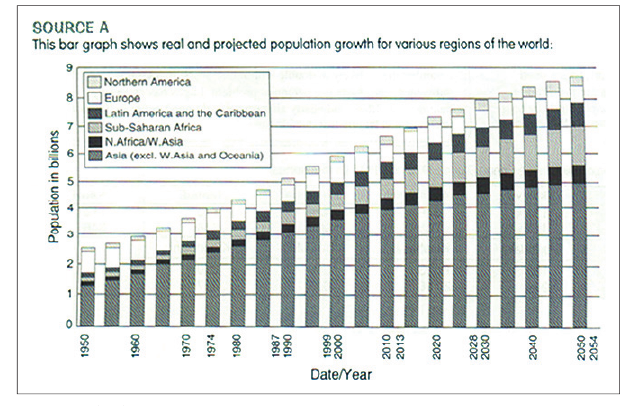
Source : Textbook 1 , p. 91 FIGURE 3: A graph revealing a time frame for post-colonial